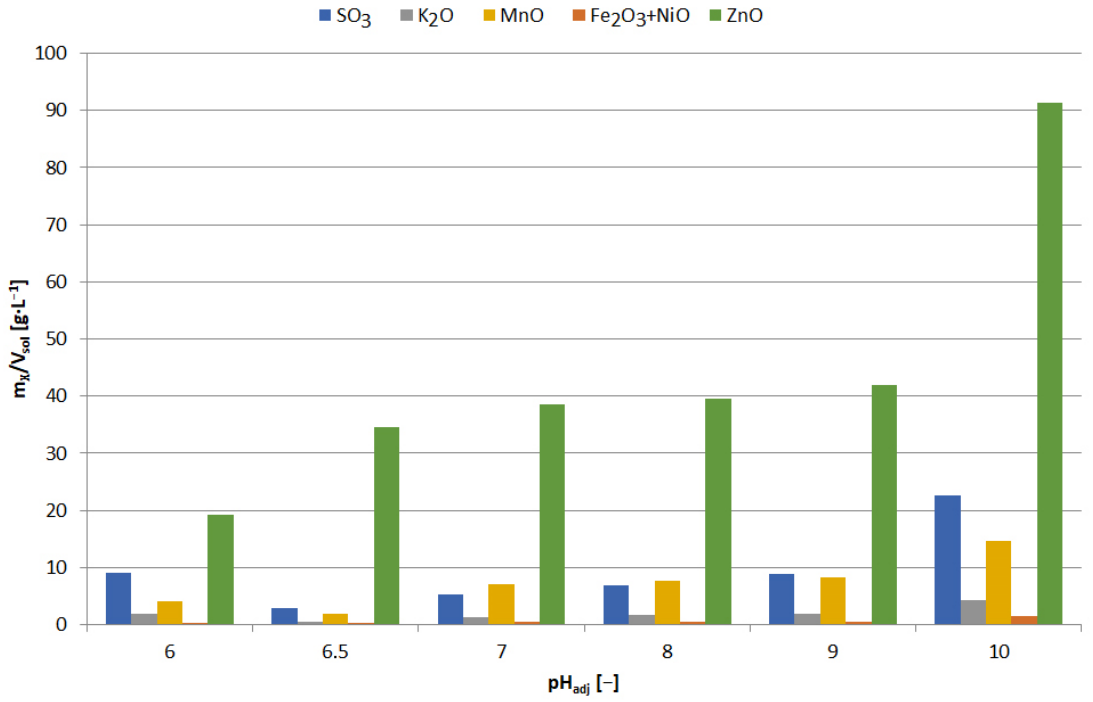
Figure 31. Effect of adjusted pH (pH adj ) amount of precipitated compound (m X /V sol ) as a result of precipitation by using Na 2 CO 3 from selective leaching solution.